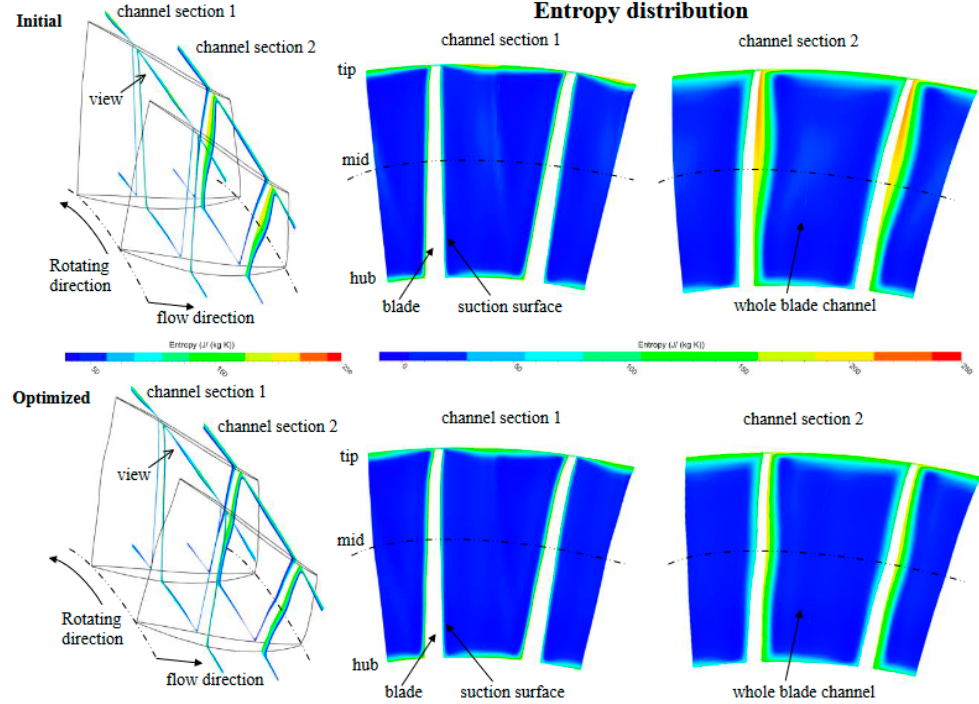
Figure 12. The entropy distribution of the initial and optimized blade.